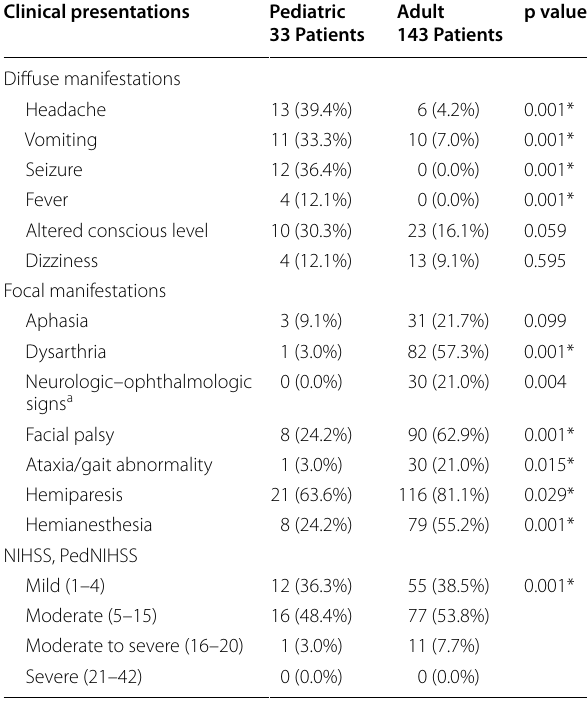
By Chi square test and Fisher exact test a Neurologic–ophthalmologic signs (squint, papilledema, visual field defect), *p value was significant